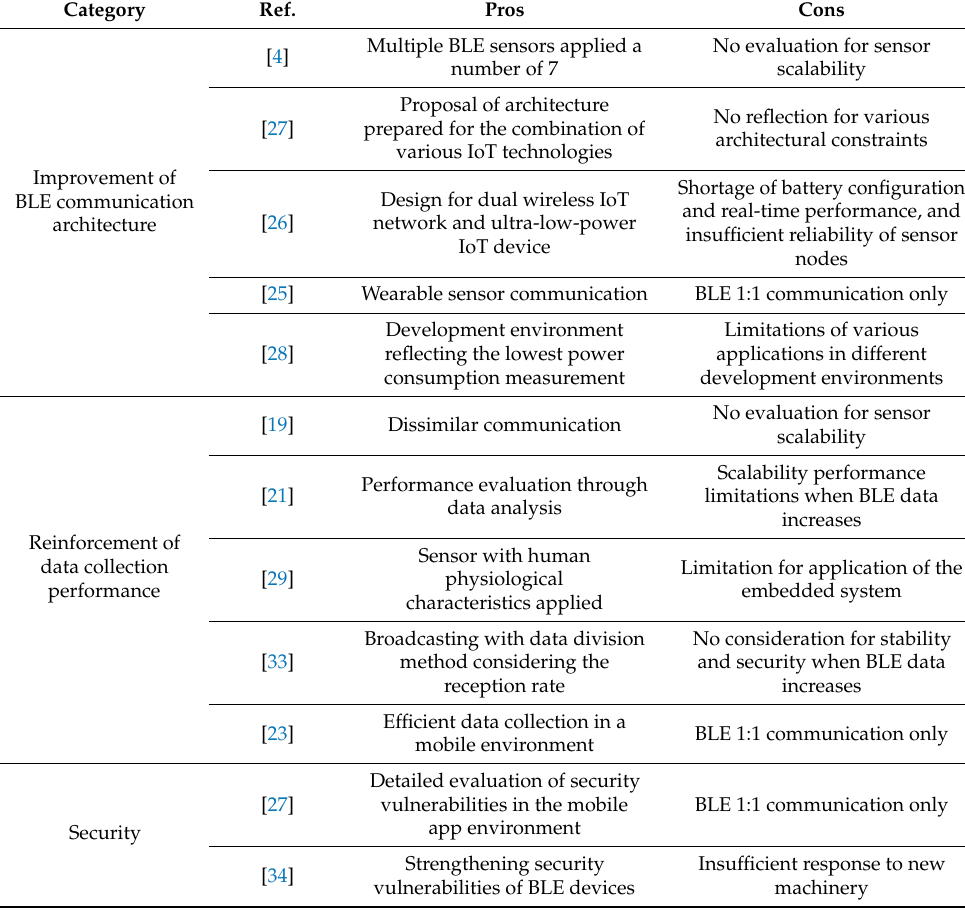
Table 1. The main advantages and disadvantages of related